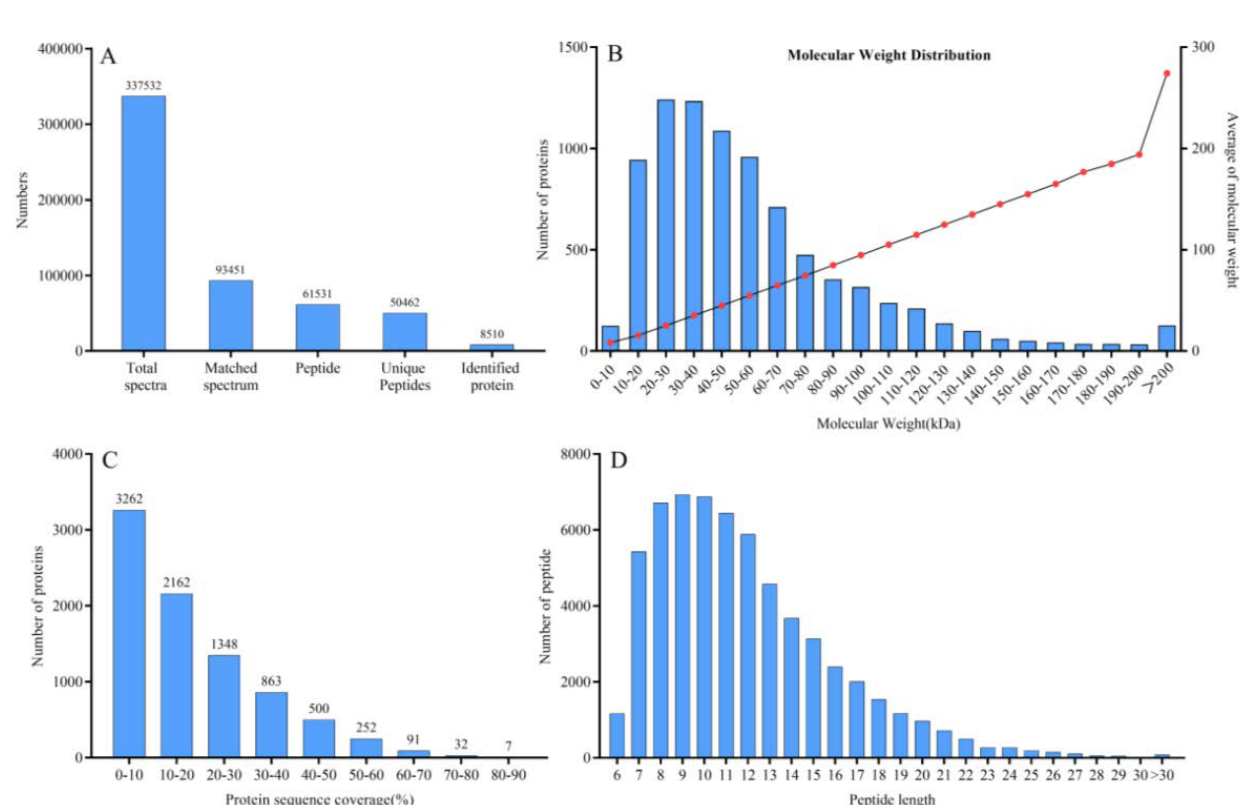
Figure 2. Quality control (QC) validation of mass spectrometer (MS) data. ( A ) Basic statistical data of MS results. ( B ) Molecular weight distribution of proteins. ( C ) Proteins’ sequence coverage. ( D ) Length distribution of all identified phosphorylated